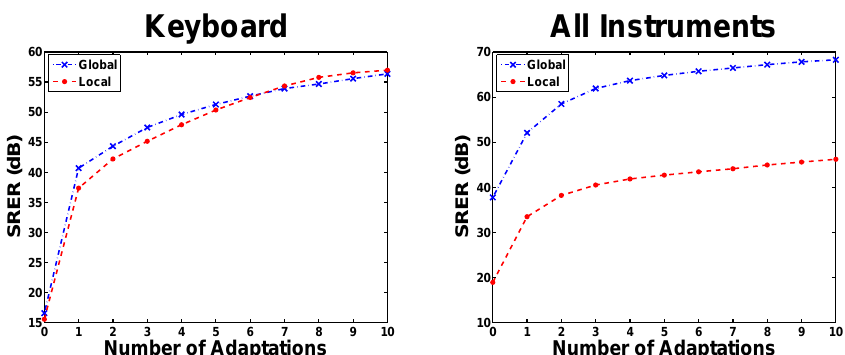
Figure 4. Plot of the signal-to-reconstruction-error ratio (SRER) as a function of number of adaptations to illustrate how adaptation increases the SRER in eaQHM. Iteration 0 corresponds to QHM initialized with the full-band harmonic spectral template.